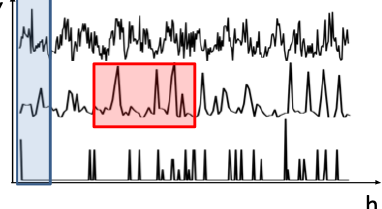
Figure 1. Representation of the averaging variables to estimate performance.